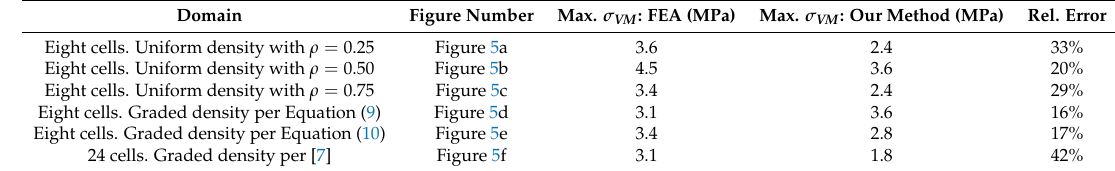
Table 4. Maximum von Mises stress values of direct FEA of the lattice domain vs. our methodology. Domain Eight cells. Uniform density with ρ =